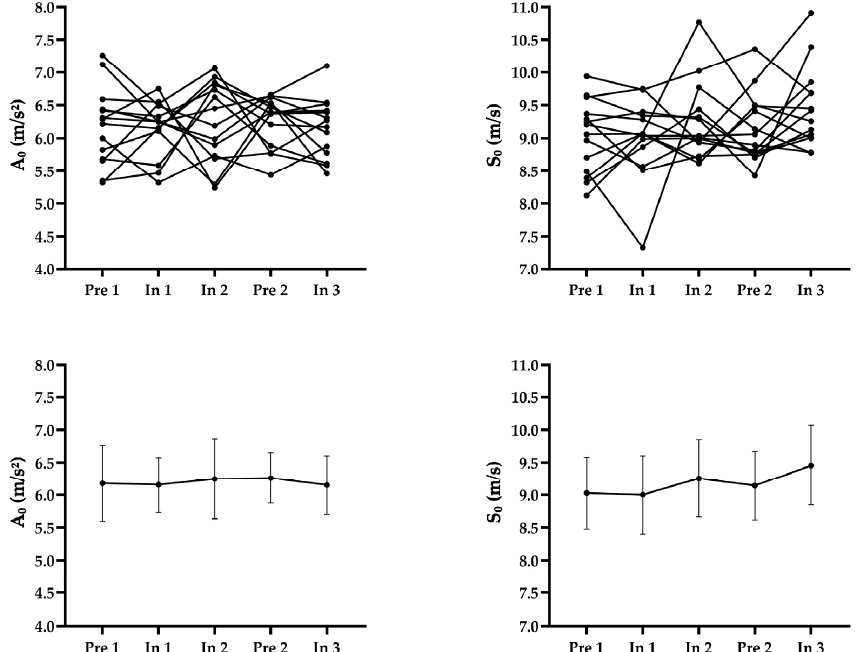
Figure 3. Individual player values (lines) of the theoretical maximal acceleration (A 0 ; upper left panel) and theoretical maximal speed (S 0 ; upper right panel) during season periods (Pre: pre-season; In: in-season). The evolution of average team values and SDs (error bars) are depicted for A 0 ( lower left panel) and S 0 ( lower right panel) during season periods.